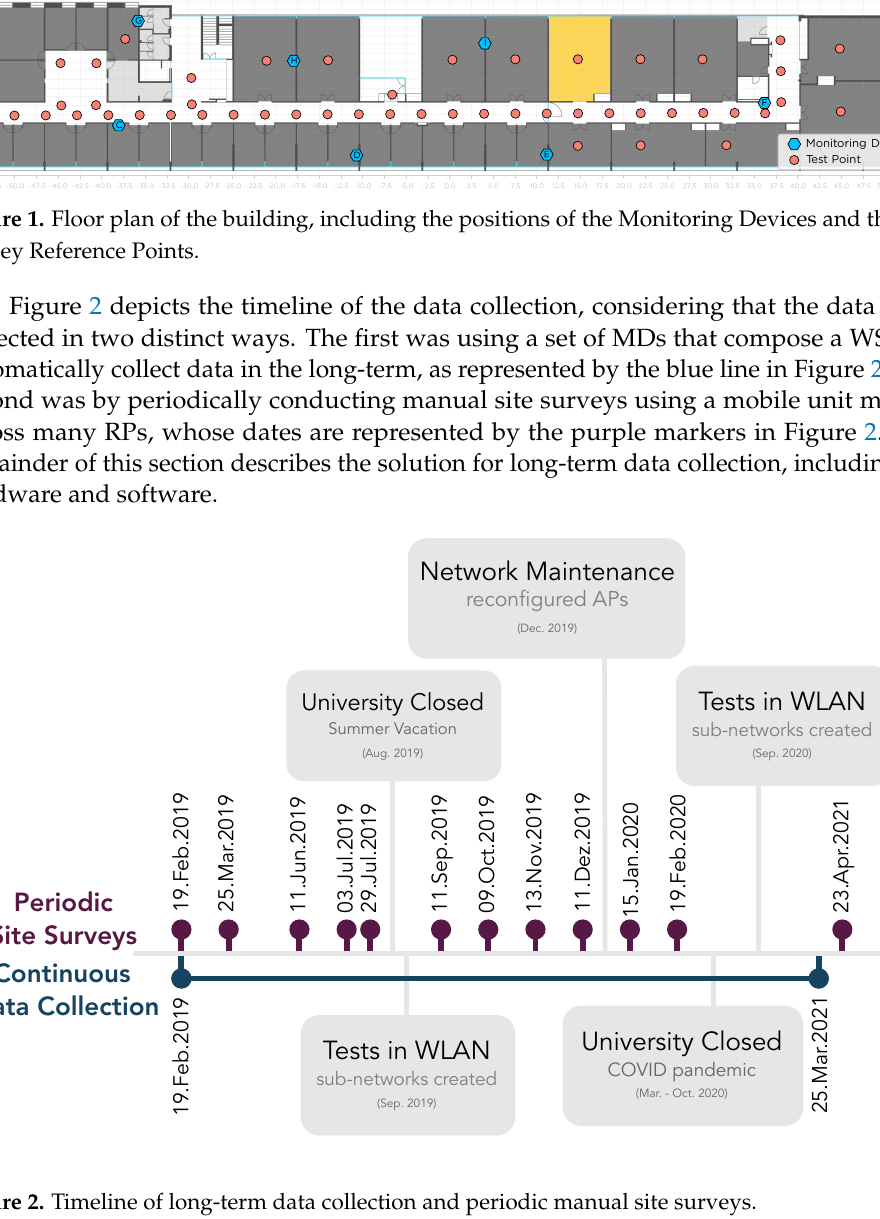
Figure 2. Timeline of long-term data collection and periodic manual site